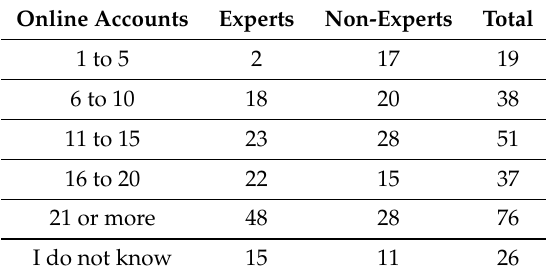
Table 16. Number of online accounts for 128 experts and 119